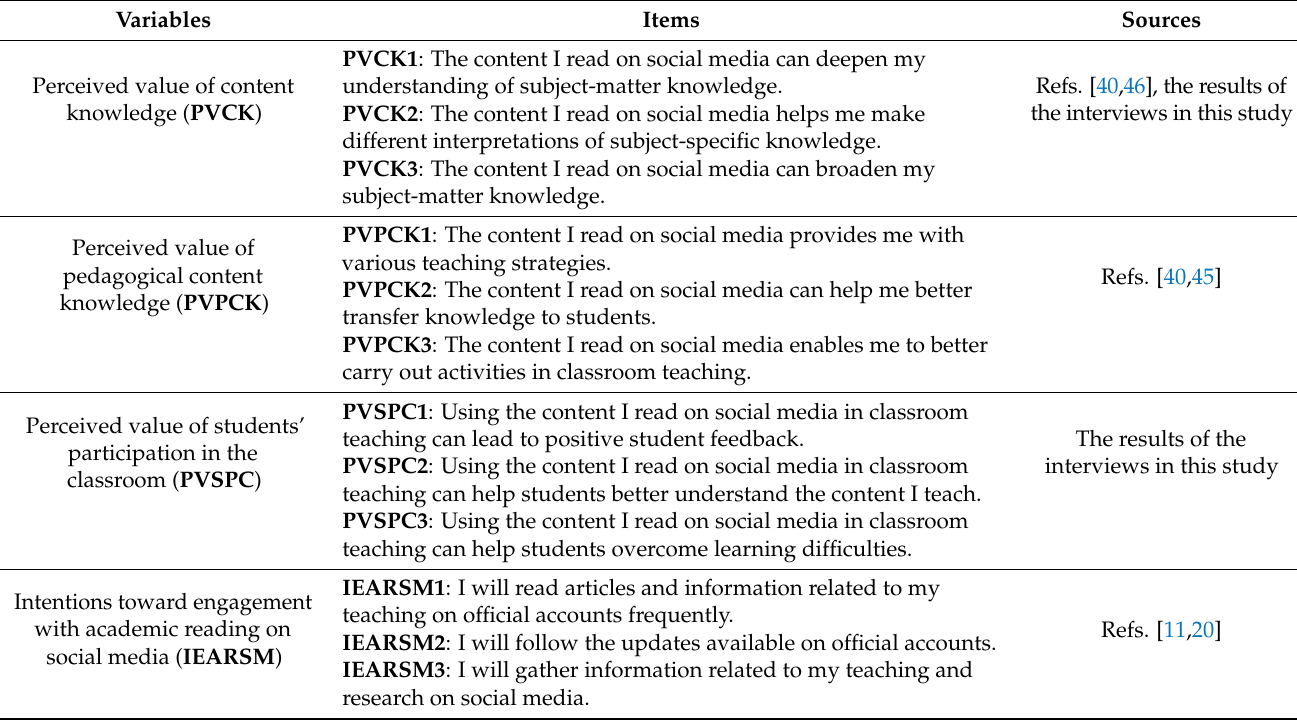
Table 1. Variables, items, and